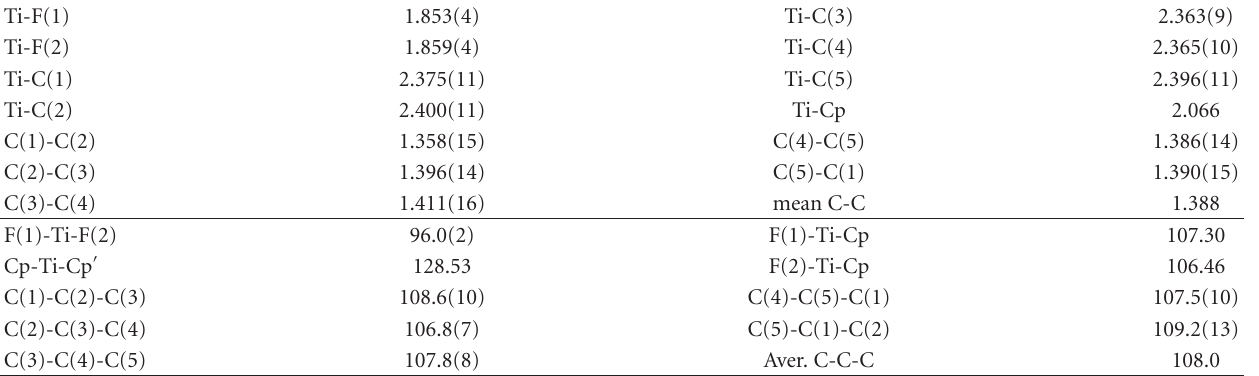
Table 2: Selected bond lengths (˚A) and angles ( ◦ ) for complex 1 . a